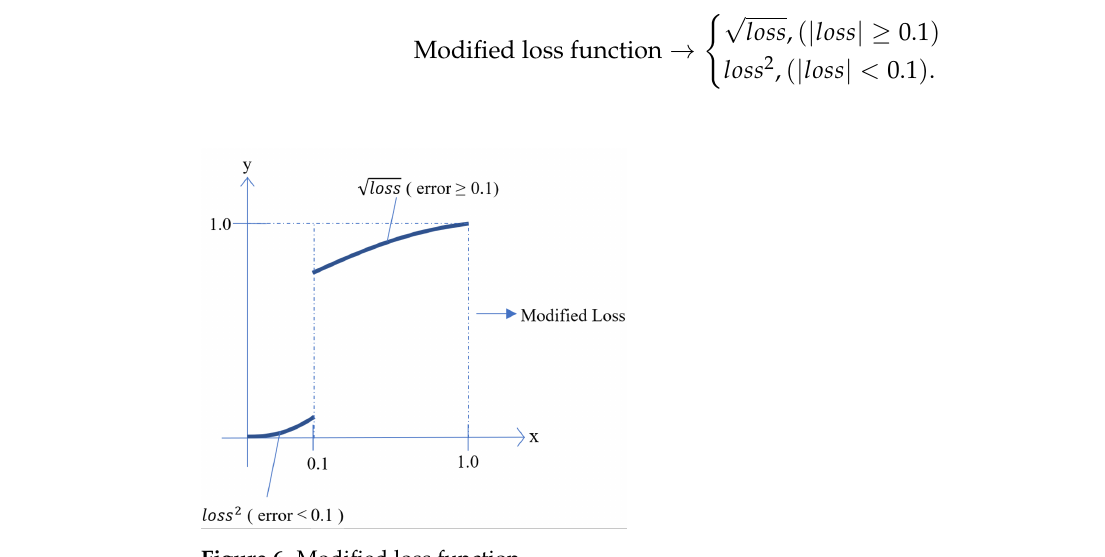
Figure 6. Modified loss